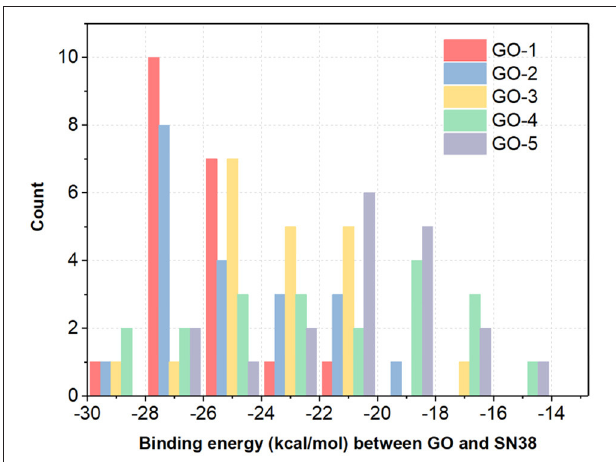
FIGURE 9 | The histogram of average binding energies (kcal/mol) between the graphene model and 121 drugs after screen with the two-layer (QGA/FF–QGA/SQM) cascade